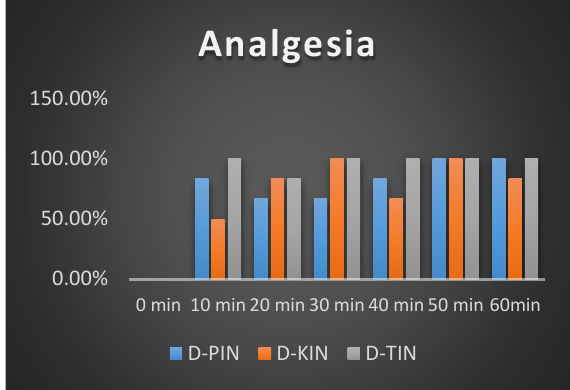
Figure, 2: Shows Analgesia in the three groups.